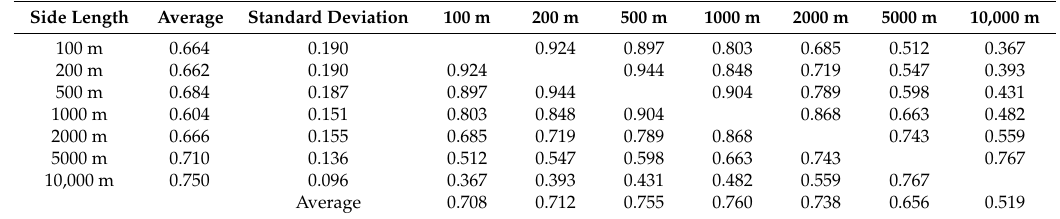
Table 7. Correlation matrix and basic statistic parameters for the 1000 m mesh control points grid.